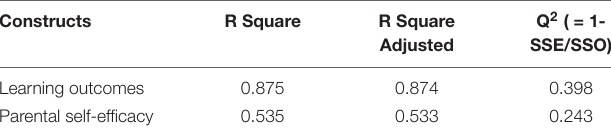
TABLE 3 | Coefficient of determination in the PLS